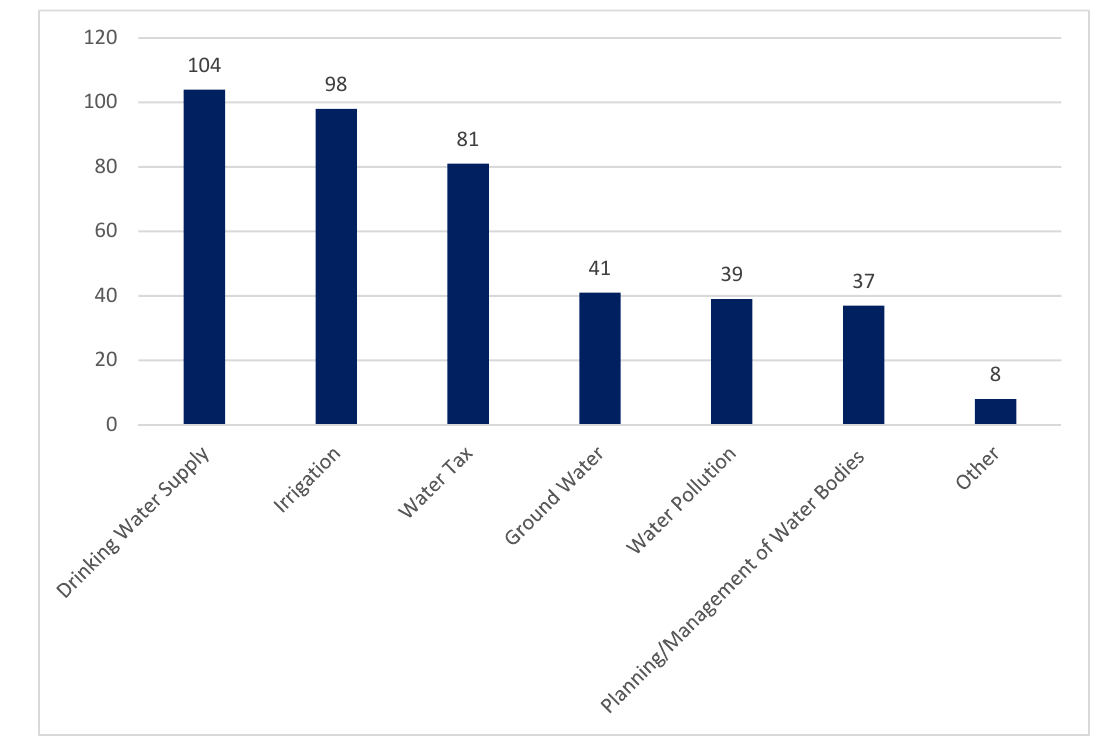
Figure 1. Distribution of water laws pre- and post-1950 .